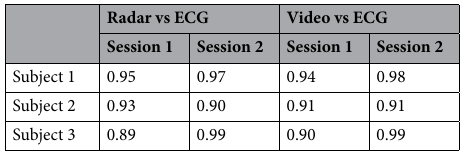
Table 1. Cross-subject and cross-sessional PCC results.